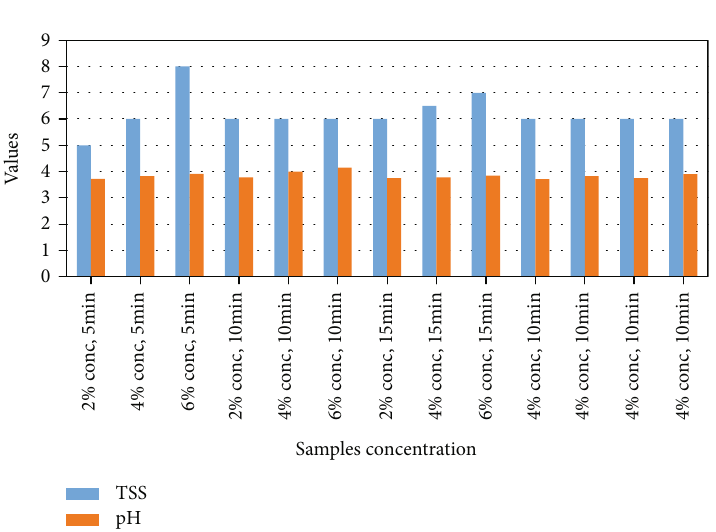
Figure 4: Total soluble solids (TSS) and pH of the sample powders.